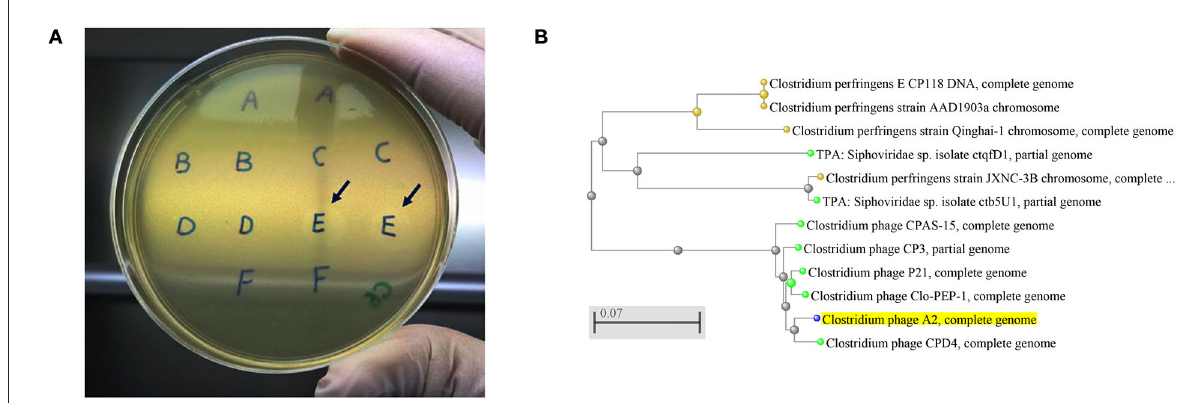
FIGURE1 (A) Clostridium perfringens bacteriophage plaques. Arrows showing the plaques produced by the strains from sample E that was collected from chicken caecal content, (B) An evolutionary tree of Clostridium bacteriophage strains produced by NCBI online blast tools with the Fast